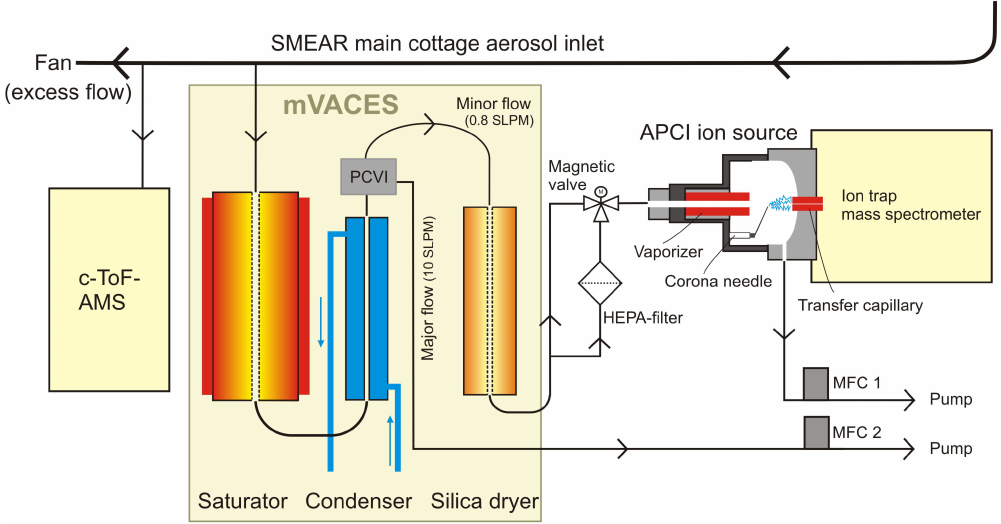
Fig. 1. Scheme of the instrumental setup of mVACES/APCI-IT-MS and C-ToF-AMS during the HUMPPA-COPEC 2010 field campaign (dimensions are not true to